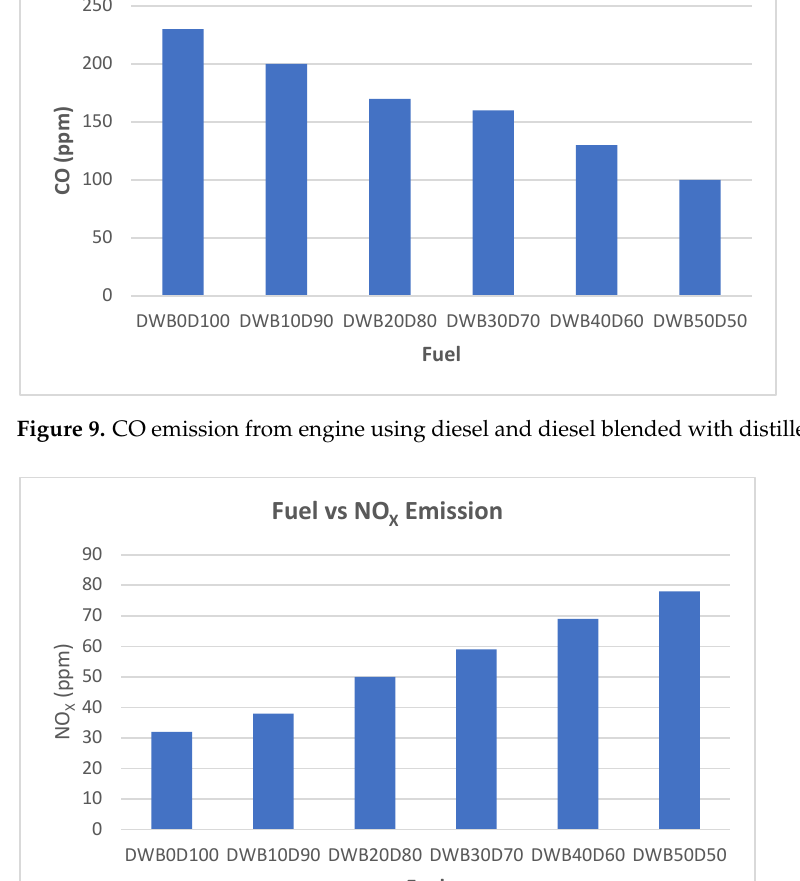
Figure 11. O 2 emission from engine using diesel and diesel blended with distilled WCO biodiesel. Figure 12. S O 2 emission from engine using diesel and diesel blended with distilled WCO biodiesel.